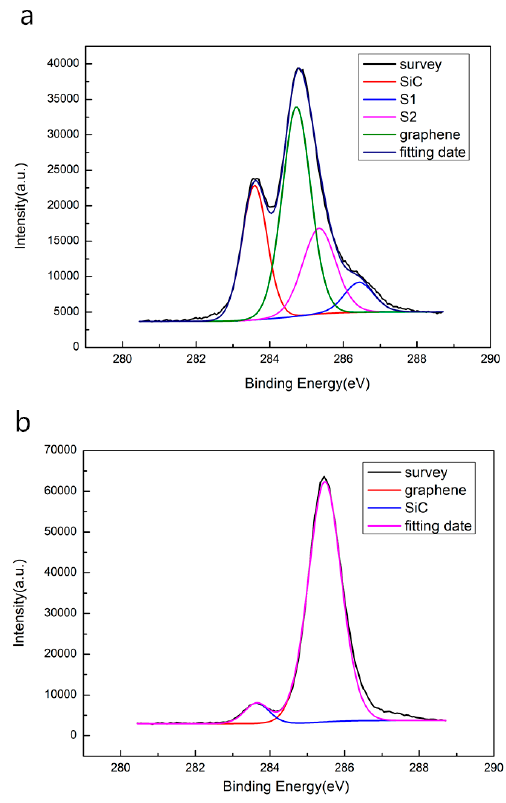
Figure 3. X-ray photoelectric spectroscopy of EG sample ( a ) and QFSG sample ( b ).